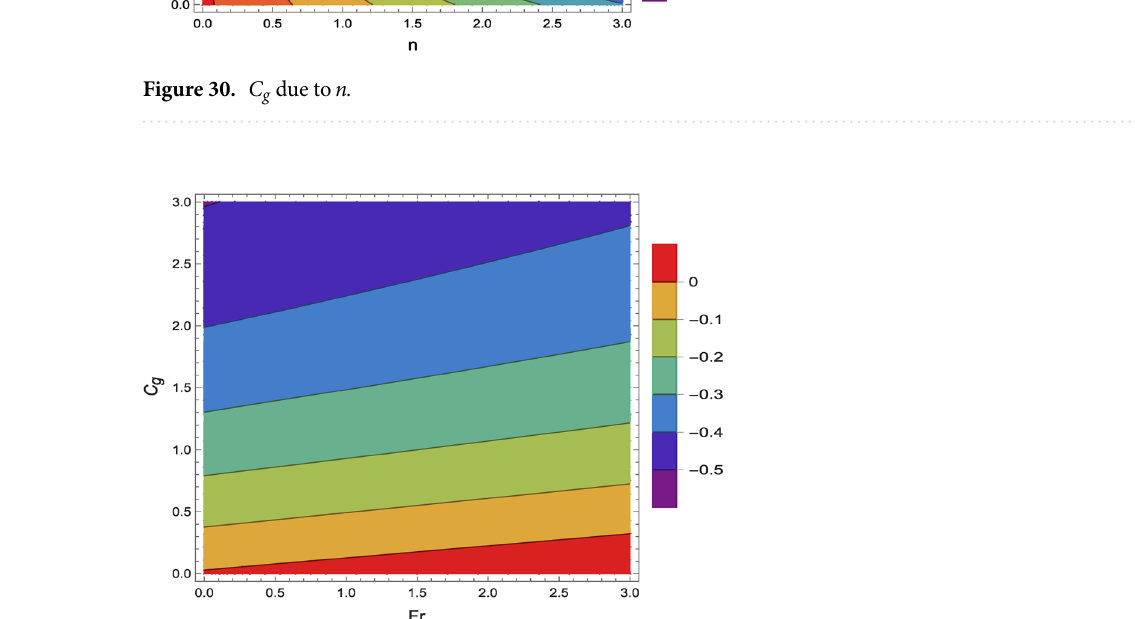
Figure 31. C g due to Fr .